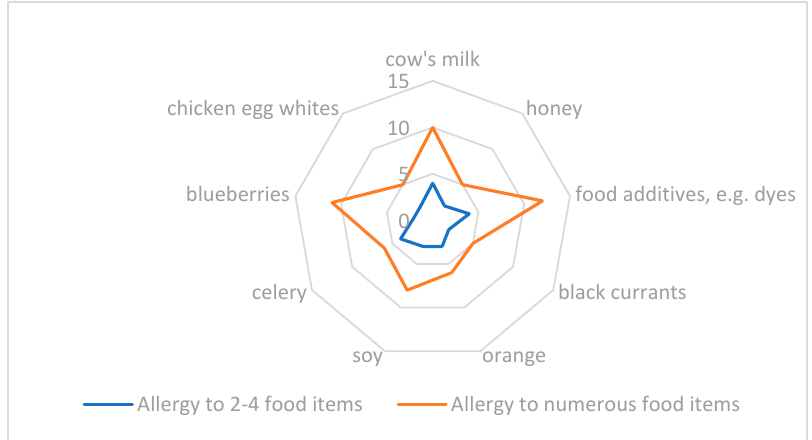
Figure 2. Main allergen and allergy to many food items.